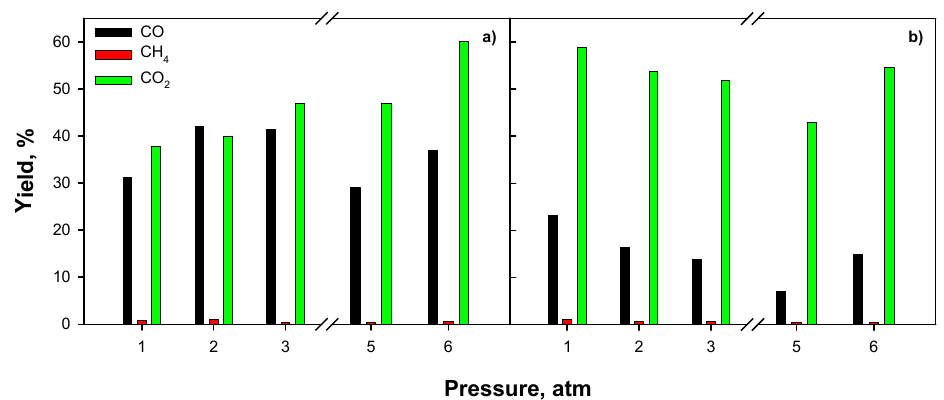
Figure 10. Gas yield as a function of pressure during steam reforming of AZ mixture on 5 Ni monolith at 720 °C; gas-phase feed composition: Solvent/H 2 O/O 2 /N 2 = 0.7/6/0/93.3; 0.7/6/0.8/92.5.